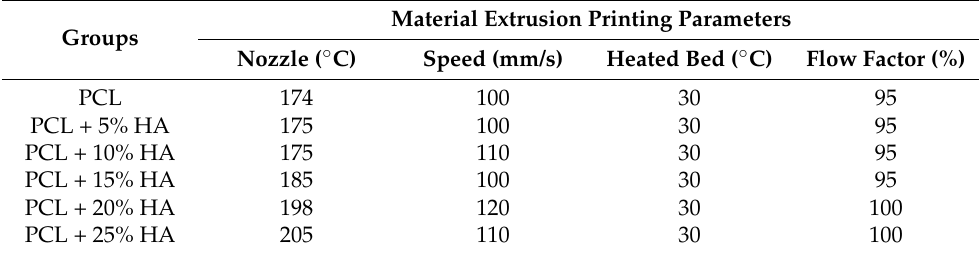
Table 2. Parameters used for 3D printing for six groups’